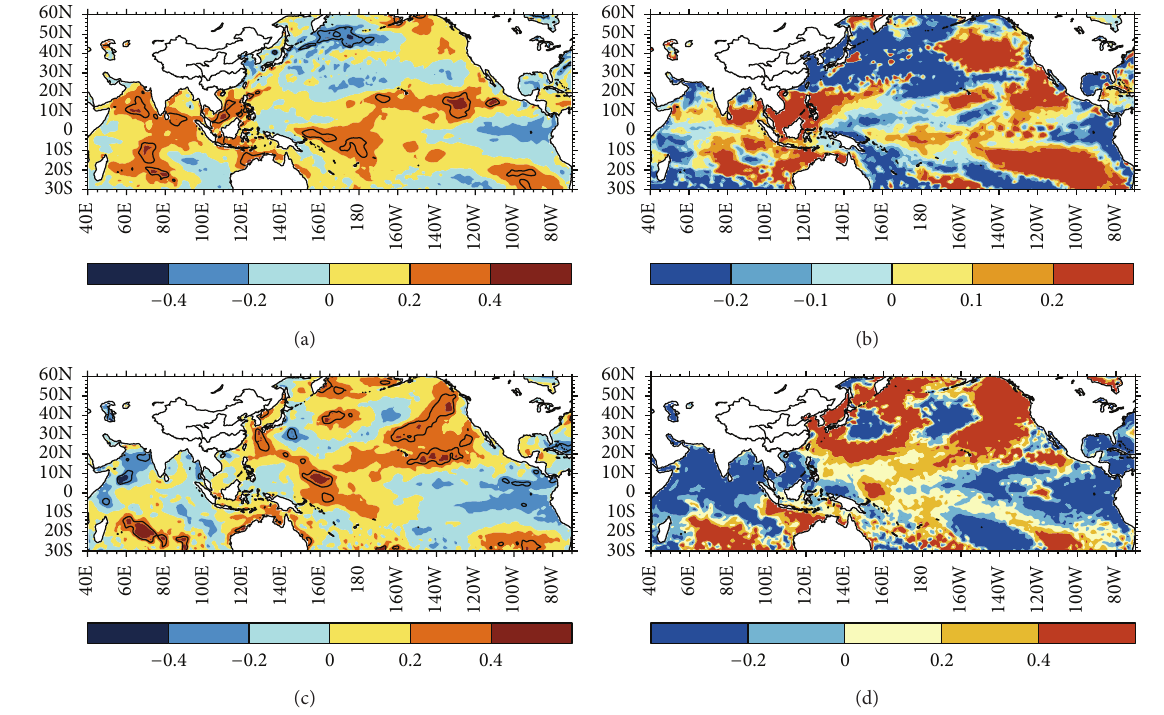
Figure 11: The correlation coefficient distribution between the total HDs in region A in summer and SSTA in (a) spring and (c) summer during 1979–2013, and the distribution of SSTA ( ∘ C) in (b) spring and (d) summer in 2013. In (a and c), long-term trend is removed, and solid line denotes the correlation coefficient significant at the 0.05